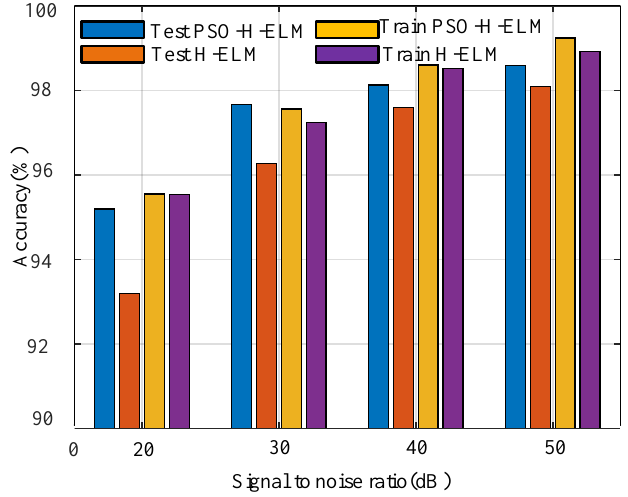
Figure 6. Test and training accuracy histogram.